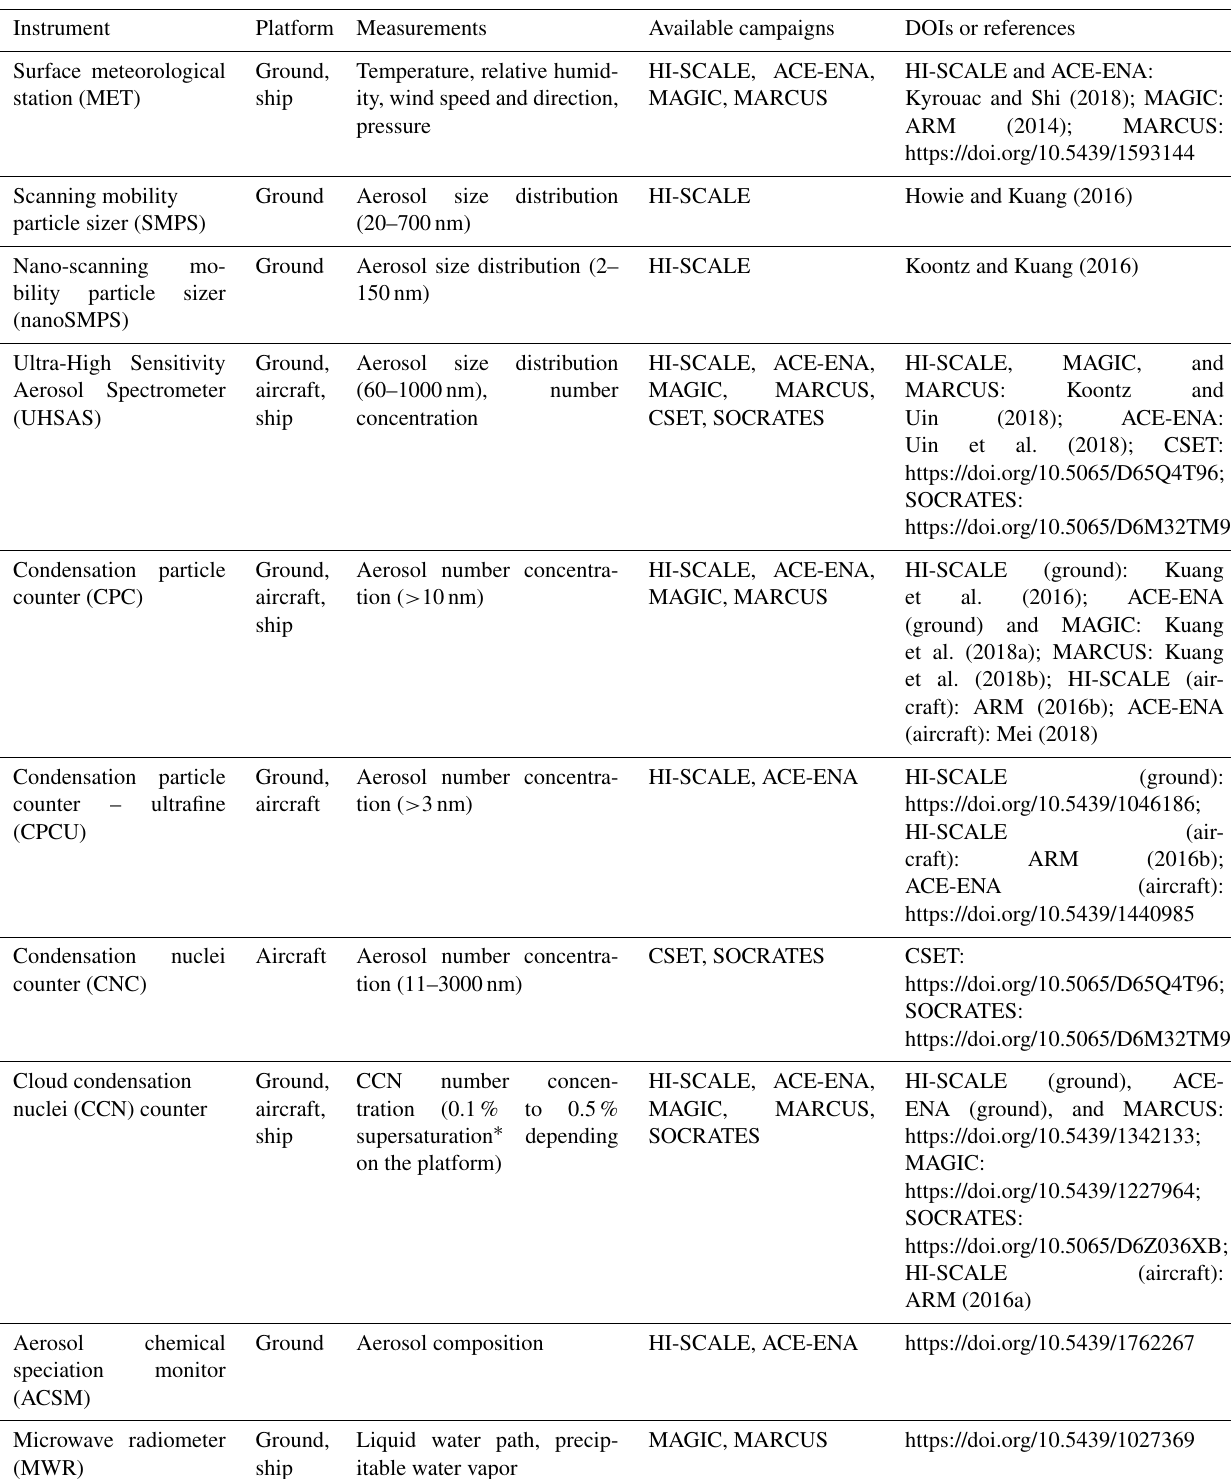
Table 2. List of instruments and measurements used in ESMAC Diags v1.